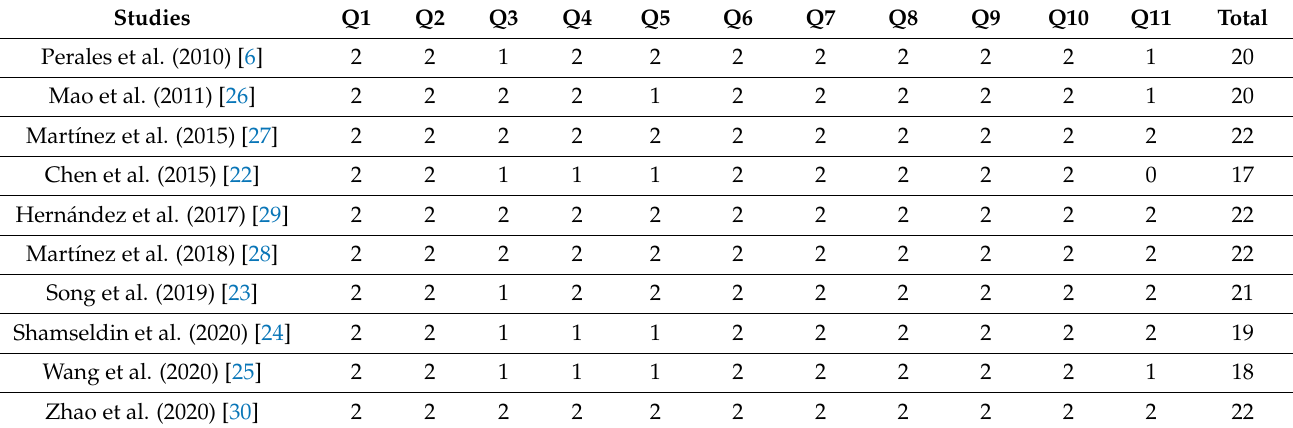
Table 4. Quality assessment analysis using STROBE scale for observational studies.